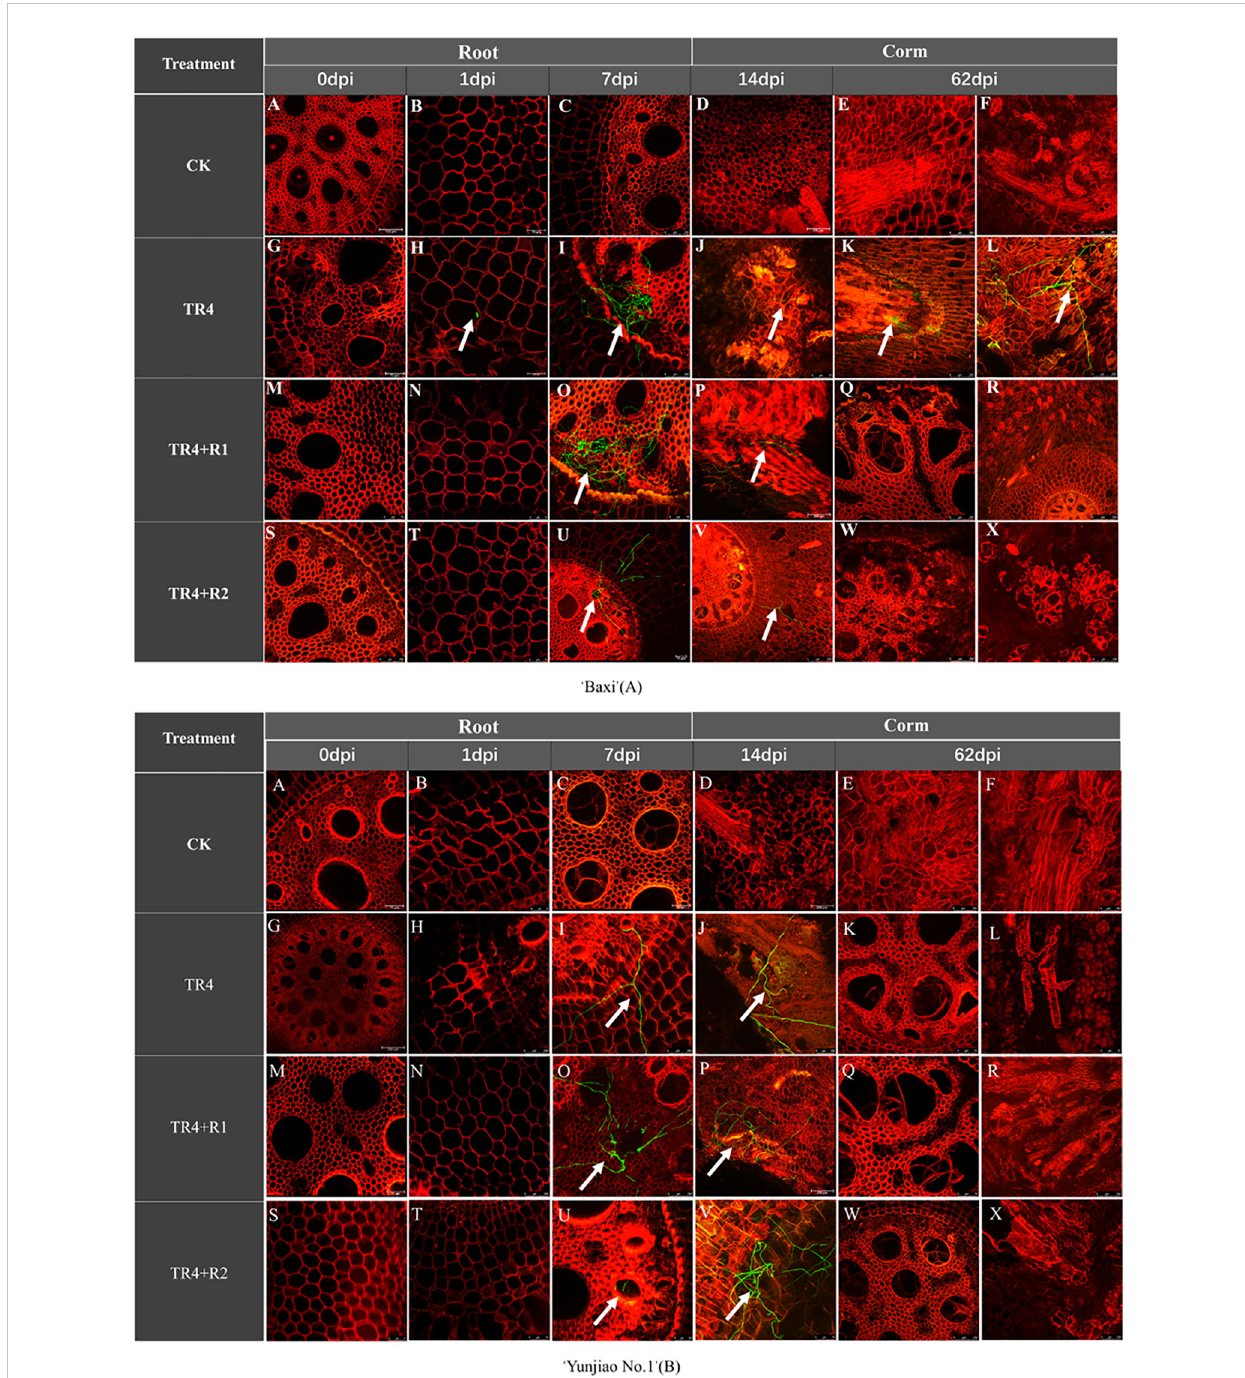
FIGURE 5 Hyphae expansion and infection in the root and corms of banana cultivar ‘ Baxi ’ inoculated with green fl uorescent protein-tagged TR4 isolates at different time points (0 dpi, 1 dpi, 7 dpi, 14 dpi and 62 dpi). The TR4 hyphae was indicated by white arrows in the plant tissues. Photographs were taken under 488 (GFP) channel and 561 (RFP) channels (A-X). Bar = 250 m m in A, C, D, E, F, I, K, L, P, Q, R, S, U, V, W and X of ‘ Baxi ’ (A) ; Bar = 75 m m in B, G, J, M, N, O and T of ‘ Baxi ’ (A) ;Bar = 250 m m in D, E, G, H, I, N, O, P, R and W of ‘ Yunjiao No.1 ’ (B) ; Bar = 75 m m in A, B, C, F, J, K, L, M, Q, S, T, U, V and X of ‘ Yunjiao No.1 ’ (B)